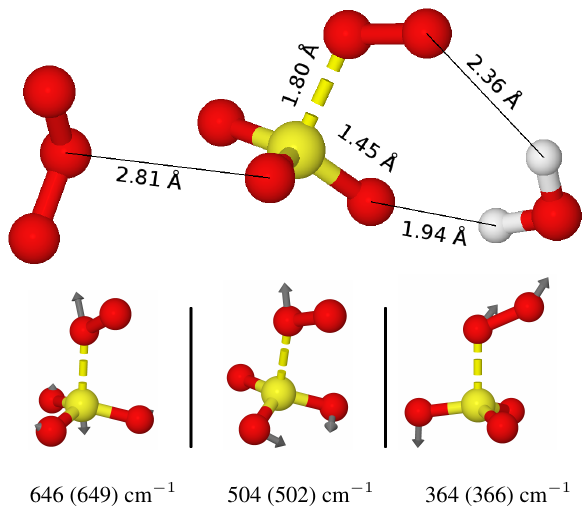
Fig. 2. Top: the molecular complex between O 2 SO − Fig. 2. Top: The molecular complex between O 2 SO − O 3 including some descriptive bond lengths. Removing either the O 3 including some descriptive bond lengths. Removing either the H 2 O or O 3 causes little structural rearrangement. Bottom: direc- H 2 O or O 3 causes little structural rearrangement. Bottom: Direc- tions and frequencies of the three normal vibrational modes along tions and frequencies of the three normal vibrational modes along − O the SO − 2 bond in the dehydrated (monohydrated) cluster. Sul- 3 − O 2 bond in the dehydrated (monohydrated) cluster. Sul- the SO − fur is yellow, oxygen red, and hydrogen white. 3 fur is yellow, oxygen is red, and hydrogen is white.